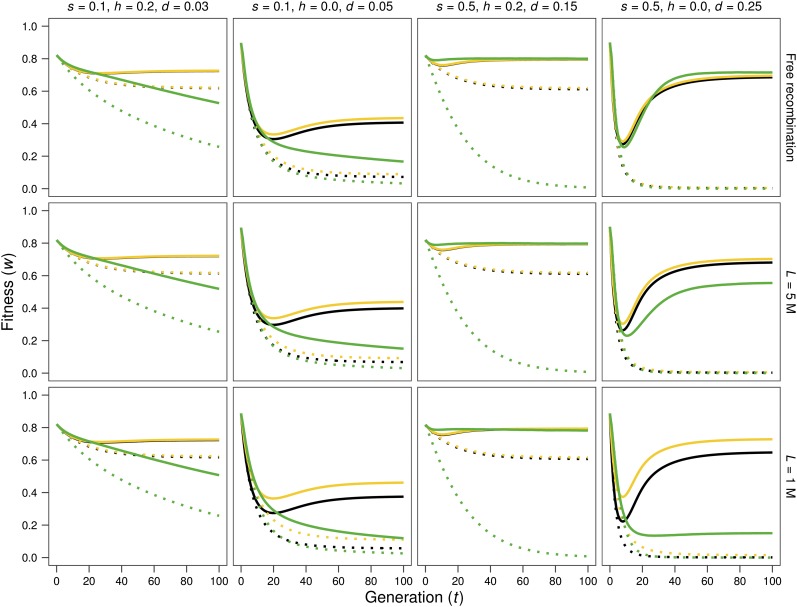
Evolution of average fitness after a reduction of population size to N = 10. Solid lines: mutation-selection-drift (MSD) results and inbreeding-purging (IP) predictions. Dotted lines: mutation-drift (MD) results and neutral predictions. Green: average fitness obtained from simulation results; black: average fitness predicted using the inbreeding load of the base population (B); yellow: average fitness predicted using the realized estimate of the inbreeding depression rate δ (see text). Note that these two predictions are on occasion so similar that the black line is completely hidden below the yellow one. Different panels represent different cases regarding the selection coefficient against homozygotes (s), the coefficient of dominance (h), the corresponding d value [d = s(1/2 – h)] and the genome length (L, given in Morgans).